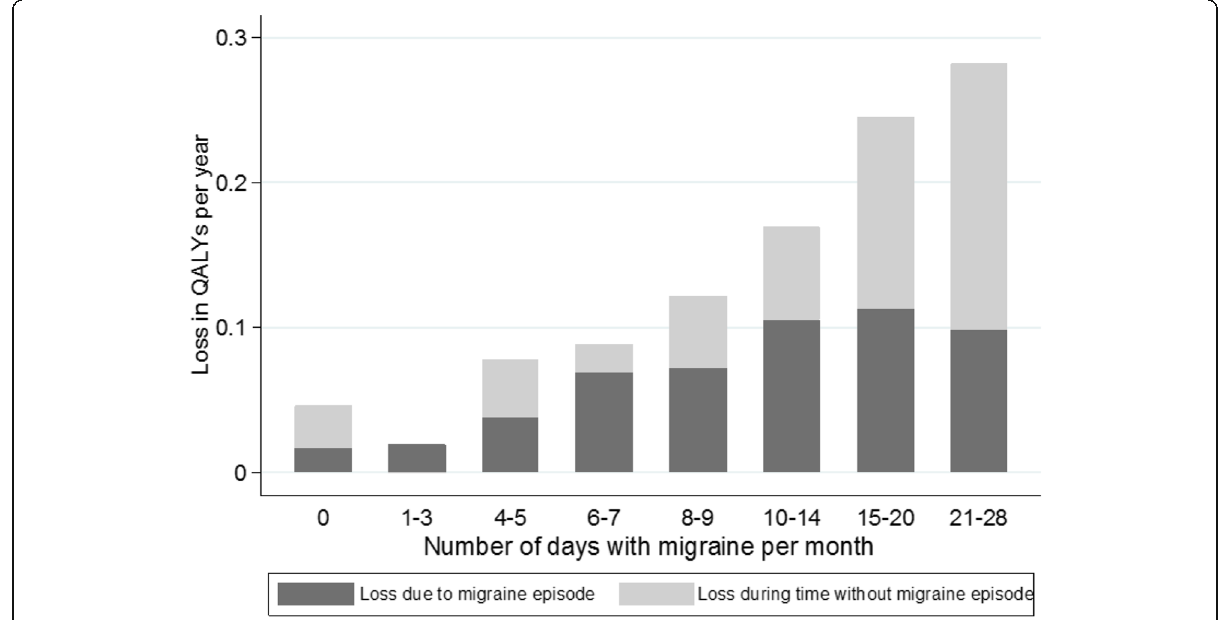
Fig. 4 Average loss in QALYs per year and person by number of migraine days per month